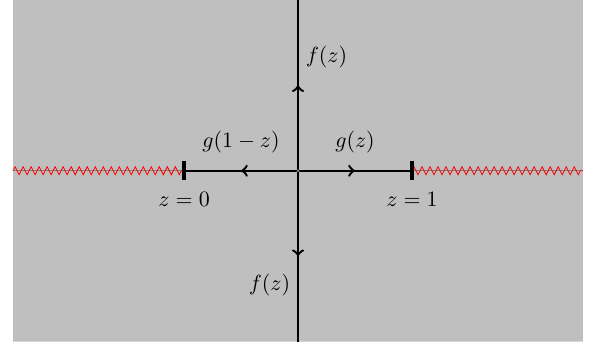
Figure 5 . The contours defining the general dispersive functional